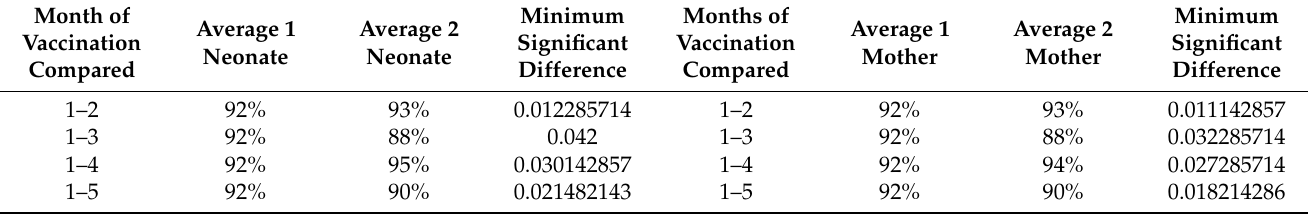
Table 3. The average percentage of neonatal and maternal neutralizing antibodies regarding the comparison of the different gestational months of